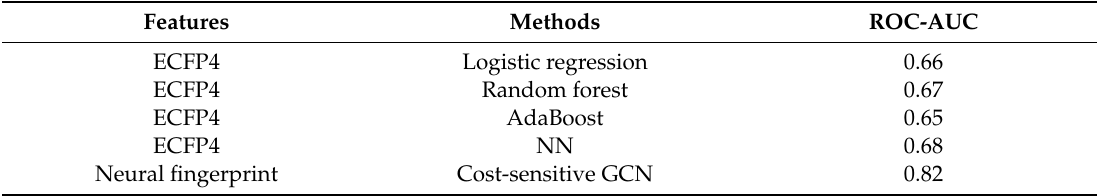
Table 1. The performance among different features and methods.